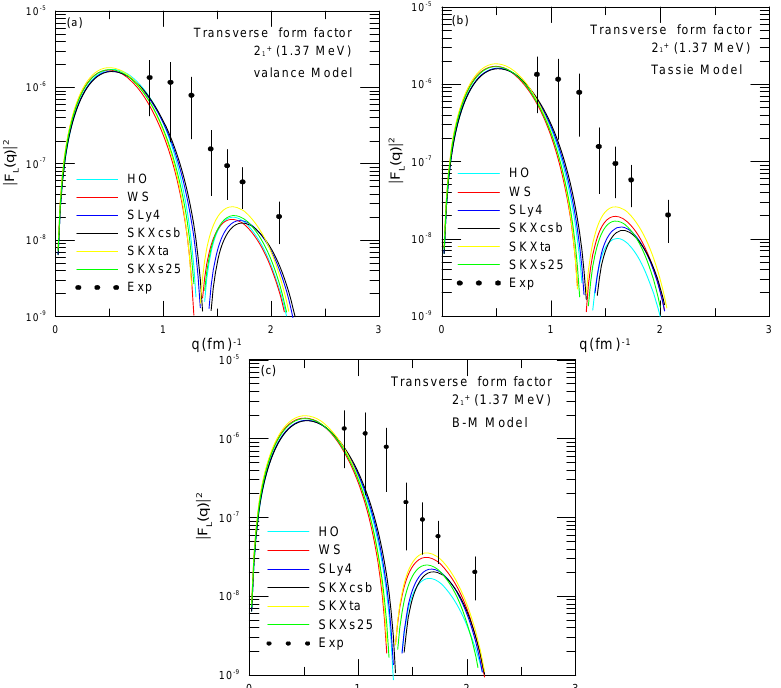
Fig.3: Theoretical transverse form factors for the first 2 + , 1.37 MeV state using different single particle potential compared with the experimental data taken from Ref. [27].